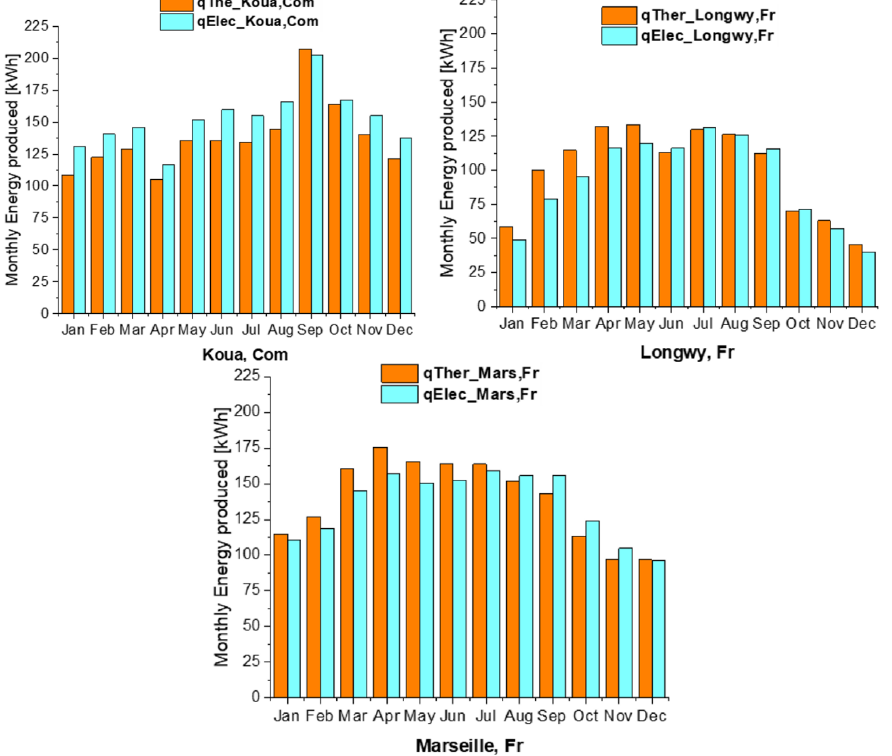
Figure 10. Monthly production of thermal and electrical energy in Koua, Longwy, and